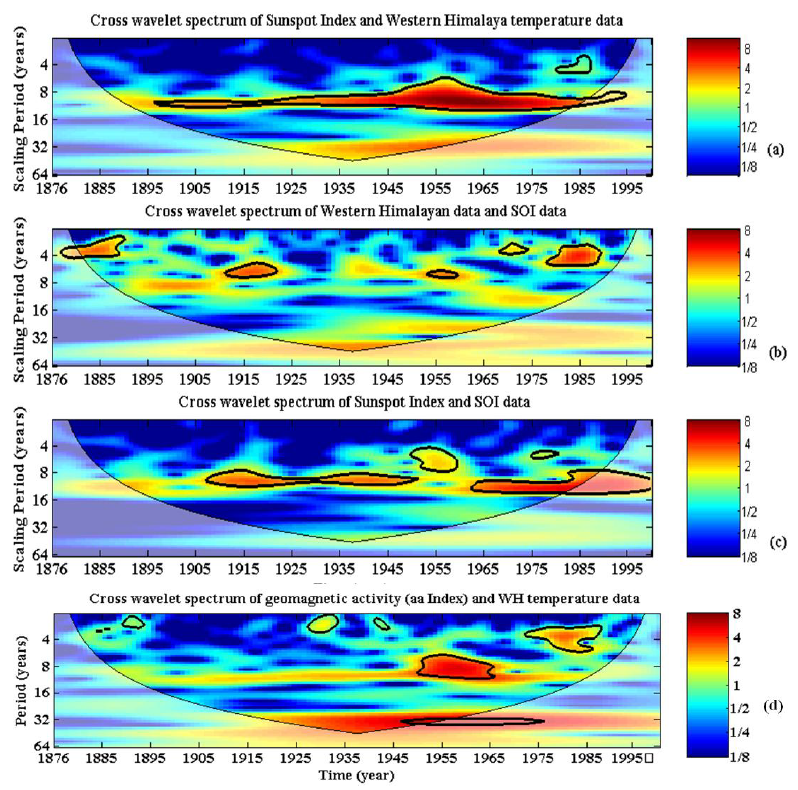
Figure 5. Cross-wavelet spectrum between (a) sunspot number–Western Himalayan data, (b) Western Himalayan–Southern Oscillation In- dex, (c) sunspot number–Southern Oscillation Index, and (d) geomagnetic aa indices–Western Himalayan data with the cone of influence (lighter shaded smooth curve) and black lines indicating significant power on a 95% level compared to red noise based on the AR(1) coeffi- cient. The legend on the right indicates the cross-wavelet power.